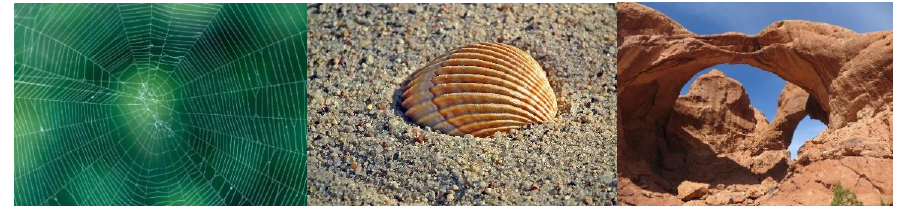
Figure 1. Left : spider web (photo by www.patternpictures.com; last accessed 2 December 2021); center : mollusk shell (photo by www.pixabay.com; last accessed 2 December 2021); right : Double O Arch in Utah’s Arches National Park: 22 m long sandstone arches (photo by Ken